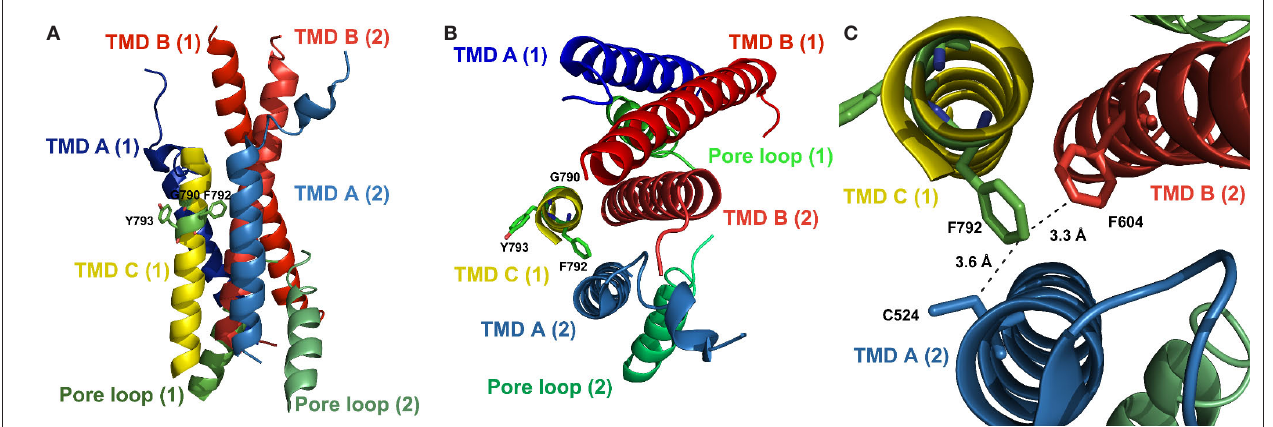
indicated. The tyrosine residue at position 793 is oriented away from the pore, facing the lipid bilayer. (C) Detailed top view; the phenylalanine residue at position 792 is oriented toward the pore and is in close proximity to C524 in TMD A and to F604 in TMD B of the neighboring subunit, suggesting an interaction between those residues and explaining the loss of function evoked by an exchange of F792 to